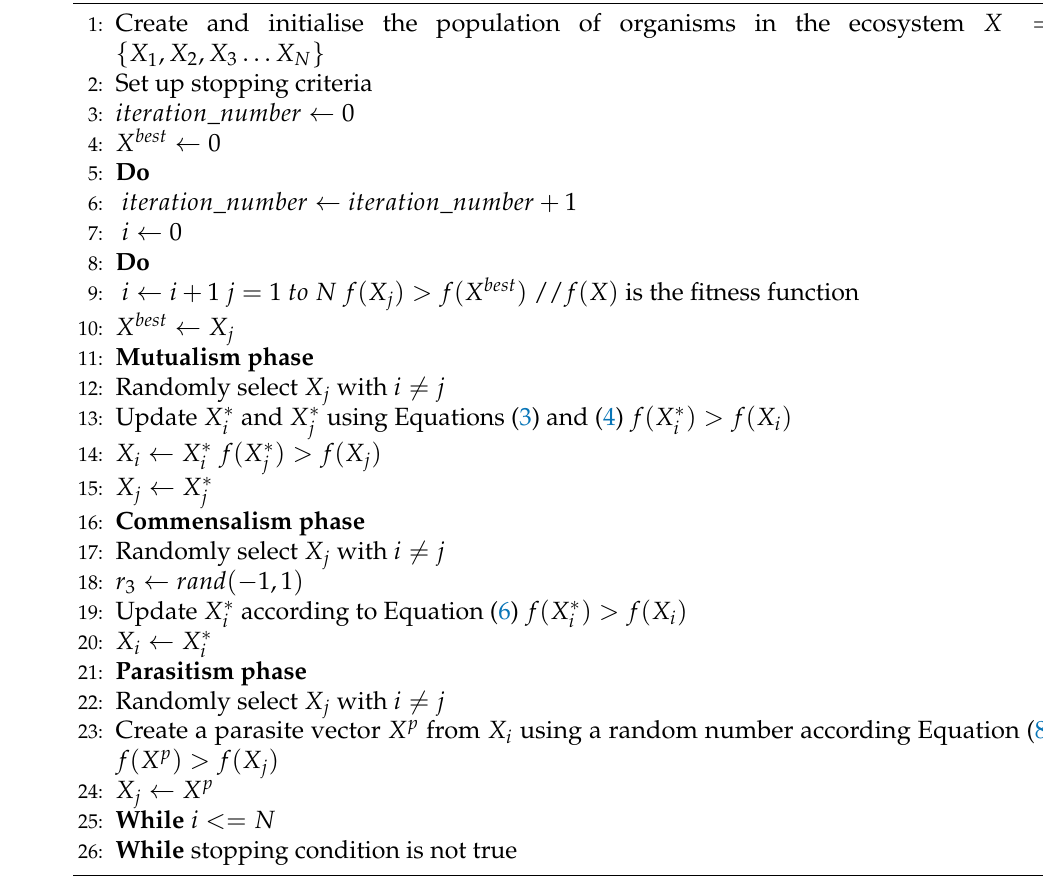
Algorithm 2 Discrete Symbiotic Organism Search